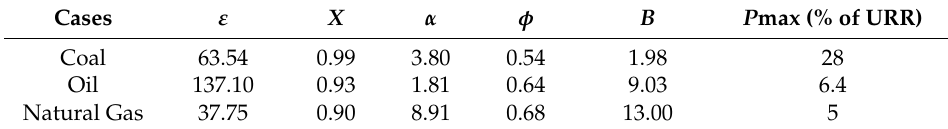
Table 2. Parameter values (unitless) from curve-fitting procedure.